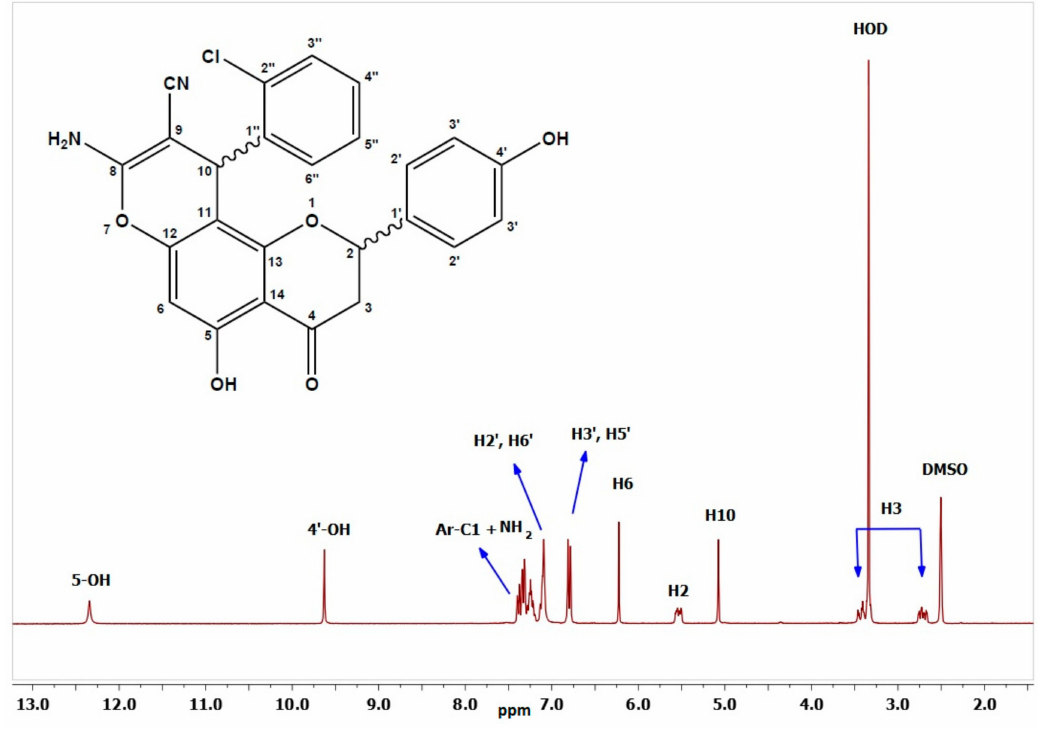
Figure 2. 1 H-NMR of Compound